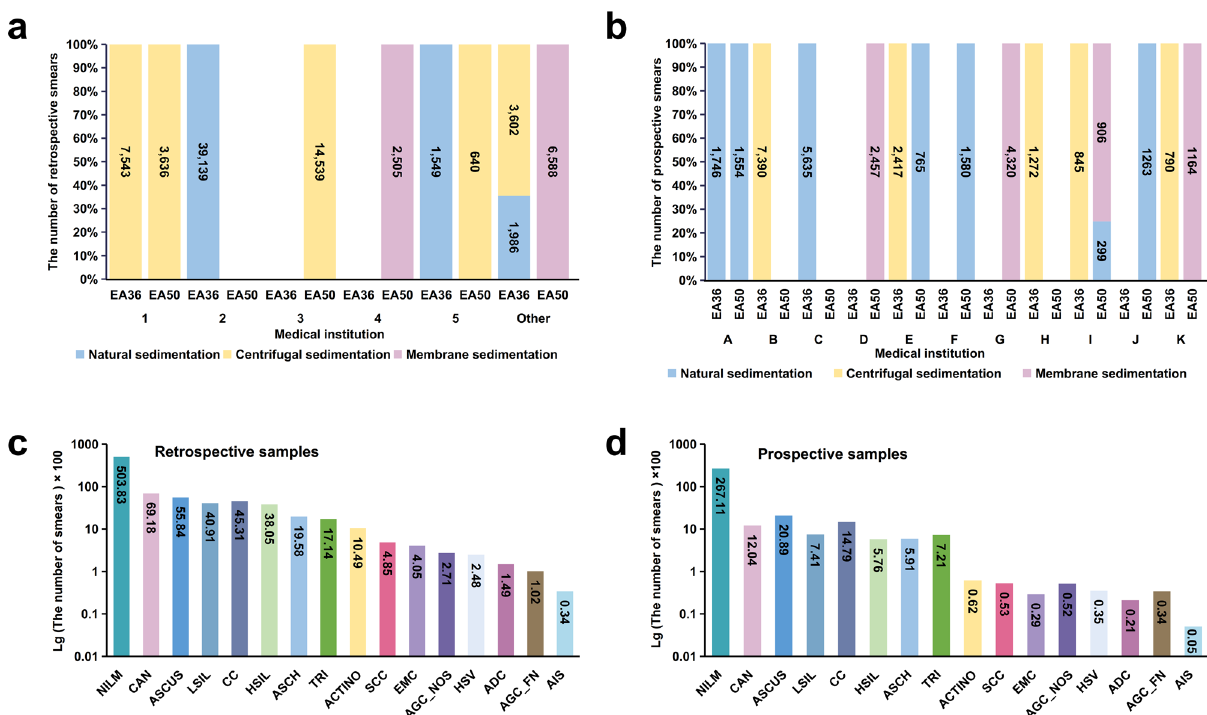
Fig. 1 Large-scale multicenter smear samples collection based on the TBS standard. a The number of retrospective smears of different preparation and staining protocols collected from multiple medical institutions ( n = 81,727). b The number of prospective smears of different preparation and staining protocols collected from multiple medical institutions ( n = 34,403). c The smear number of different TBS classi fi cation in the retrospective study. d The smear number of different TBS classi fi cation in the prospective